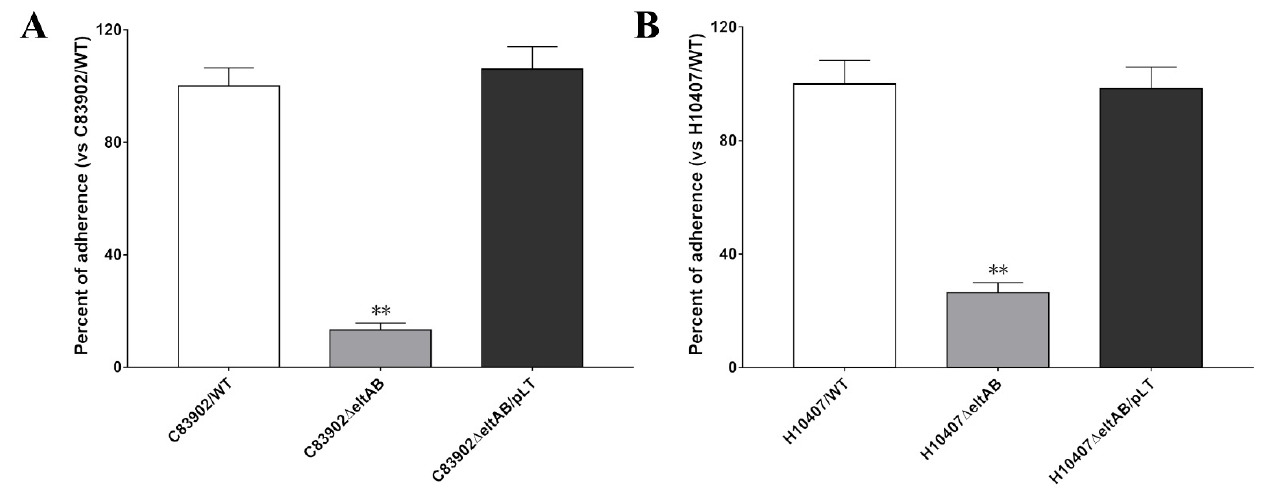
Figure 2. Adherence percentage of differing ETEC strains to intestinal epithelial cells. ( A ) Adhesion of ETEC C83902/WT, C83902 Δ eltAB , and C83902 Δ eltAB /pLT strains to IPEC-J2 cells. The adhesion index of the C83902/WT strain was assumed to be 100%. ( B ) Adhesion of ETEC H10407/WT, H10407 Δ eltAB , and H10407 Δ eltAB /pLT strains to Caco-2 cells. The adhesion index of the H10407/WT strain was assumed to be 100%. Data are expressed as mean ± SD of triplicate experi- ments. * indicates p < 0.05 and is deemed statistically significant. ** indicates p < 0.01 and is